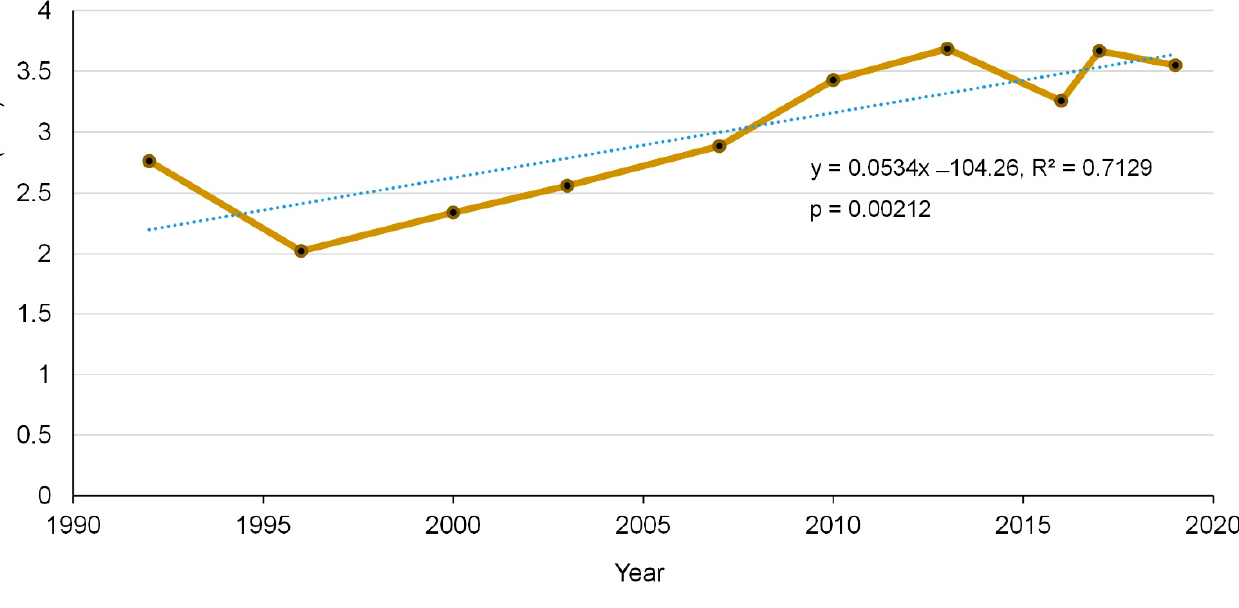
Figure 3. Historical trends of the area of cover of aquatic invasive alien plants in the study area of the period 1992–2019. Table 5. Area changes of aquatic invasive alien plants in the study area from 1992 to